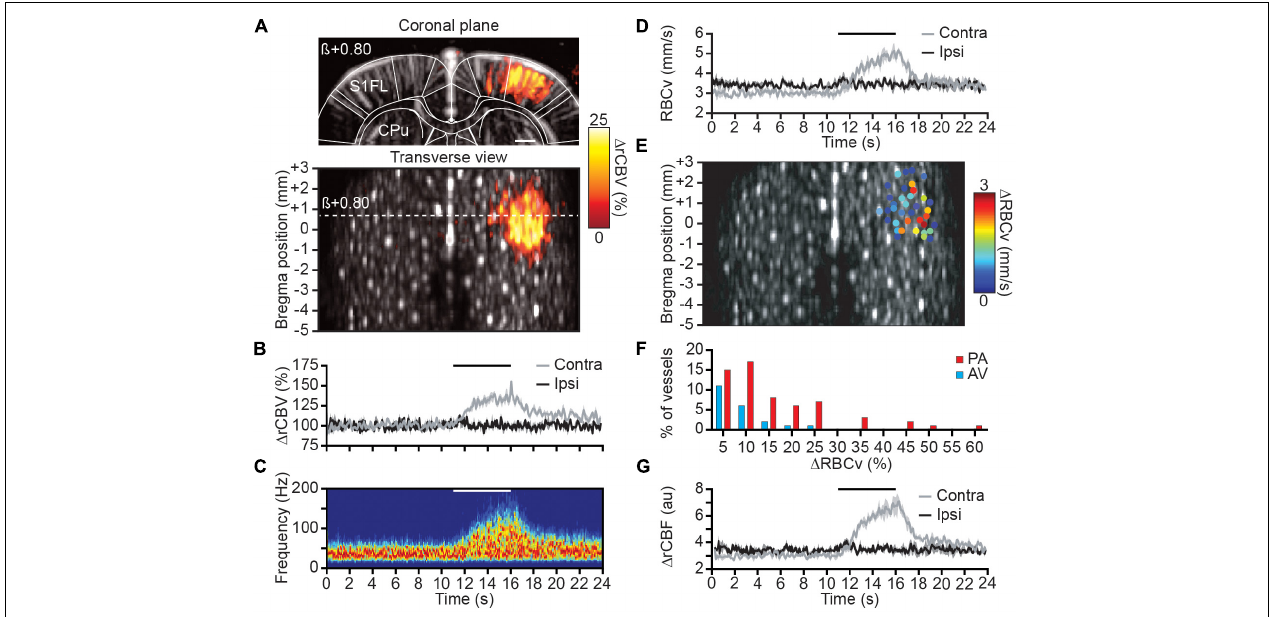
FIGURE 3 | Spatial distribution and hemodynamic quantification of activated vessels. (A) Coronal µ Doppler image (top panel) and transverse view (bottom panel) overlaid with the color-coded correlation map highlighting rCBV changes (%) in the contralateral S1FL region during forelimb stimulation. (B) Average rCBV increase in a single cortical S1FL vessel contralateral (gray) and ipsilateral (black) to the forepaw stimulation (horizontal black line). (C) Spectrogram (Hz) from a single penetrating arteriole located in the S1FL contralateral to the forepaw stimulation (horizontal white line). (D) RBCv (mm/s) changes in the same vessels than in (B) . (E) Spatial location of cortical vessels showing RBCv changes (%) in response to forelimb stimulation. The distribution of RBCv increase is ranging from less than 1 mm/s up to 3 mm/s. (F) Distribution of the RBCv increase for all activated vessels. (G) rCBF (au) changes in the same vessels than in (B) . All traces are mean ± sem of 3 trials. S1FL, primary somatosensory cortex of the forelimb; CPu, caudate putamen; β , bregma; scale bar = 1